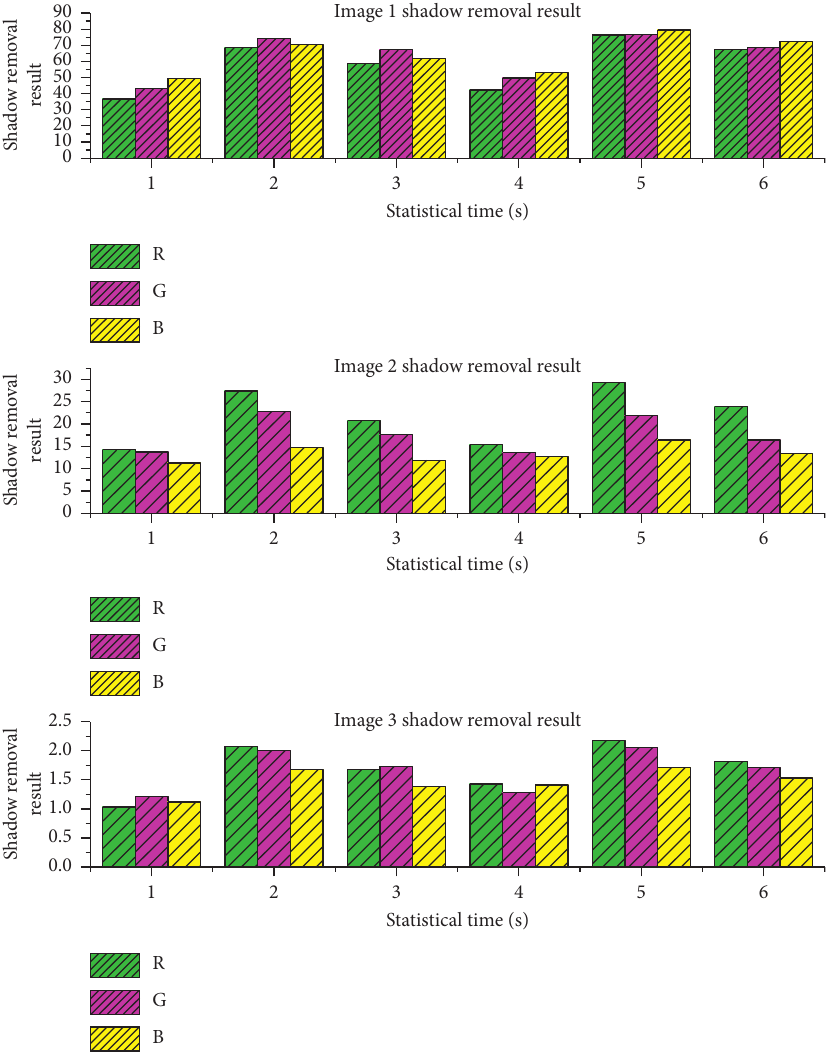
Figure 6: Statistical results before and after removal of